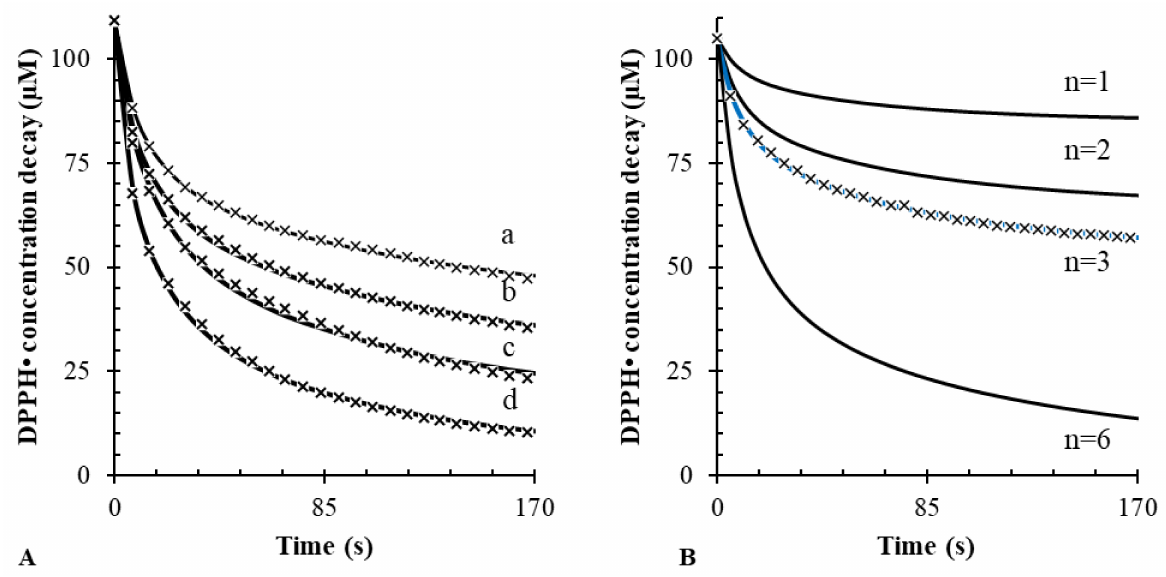
Figure 2. ( A ) Best fitting considering both Equations (1) and (2) at different concentrations of gallic acid (a: 10; b: 20; c: 50; d: 100 µ M) vs. 100 µ M DPPH • ; ( B ) the precision of the software while calculating n is reported. Only for n = 3 was best fitting